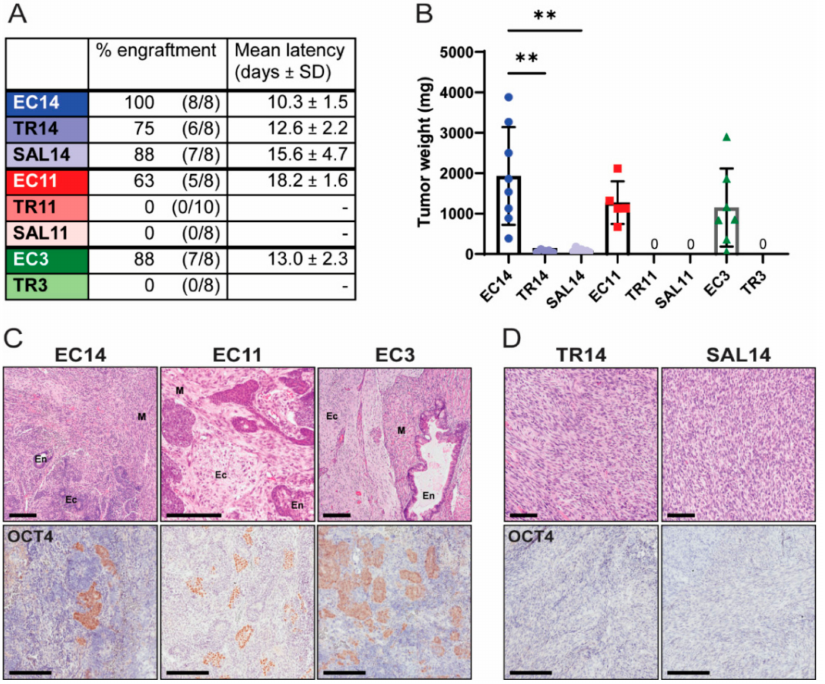
Figure 4. Thioridazine- and salinomycin-differentiated cells have reduced tumorigenic potential. ( A ) The indicated EC cells or the corresponding differentiated derivatives were injected subcuta- neously into immune-compromised mice. Data show the percent engraftment (number of tumors formed/number of injection sites) and mean latency (time from cell injection until tumors were palpable). ( B ) Weight of tumors derived from EC or differentiated cells at endpoint (two weeks after initial tumor detection for EC14, TR14, SAL14, and EC3 cells, or three weeks after initial tumor detection for EC11 cells). TR11, SAL11, and TR3 cells did not form any tumors. Data are mean values ± standard deviation. ** p < 0.01 (Kruskal–Wallis test). ( C ) Representative images of H&E- and OCT4 IHC-stained tumors derived from EC cells. En = endoderm, M = mesoderm, Ec = ectoderm. Scale bars = 200 µ m. ( D ) Representative images of H&E- and OCT4 IHC-stained tumors derived from TR14 and SAL14 cells. Scale bars = 200 µ